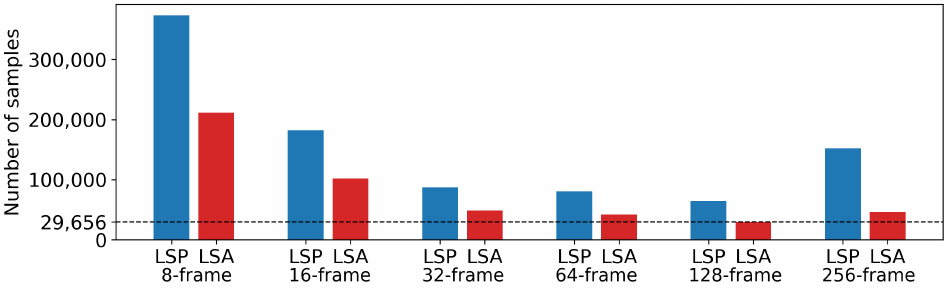
Figure 1. Total number of samples from each class (Lung Sliding Absence (LSA)/Lung Sliding Presence (LSP)) with the number of